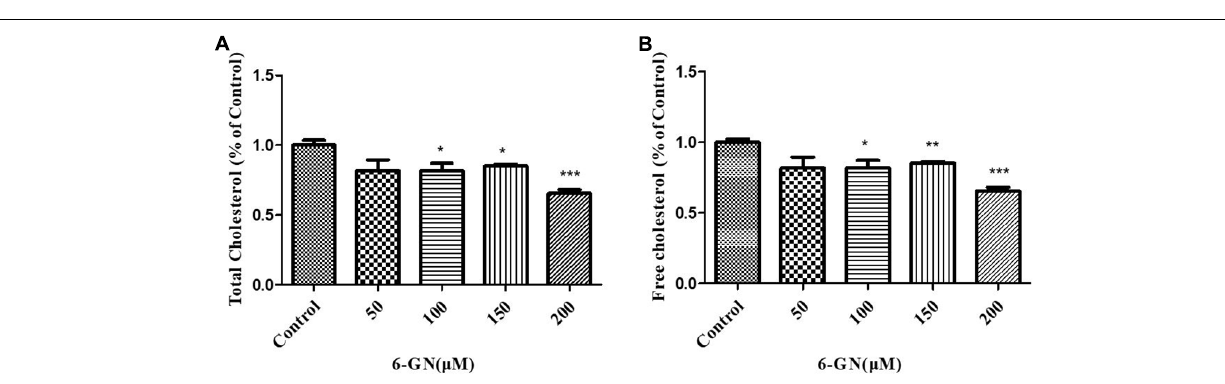
FIGURE 2 | Effect of 6-GN on total and free cholesterol in HepG2 cells. (A) Total or (B) free cholesterol in HepG2 cells disposed with or without various concentrations of 6-GN (50, 100, 150, and 200 µ M) for 24 h. Values were represented as mean + SD of three independent experiments. ∗ p < 0.05 versus control, ∗∗ p < 0.01 versus control, ∗∗∗ p < 0.001 versus